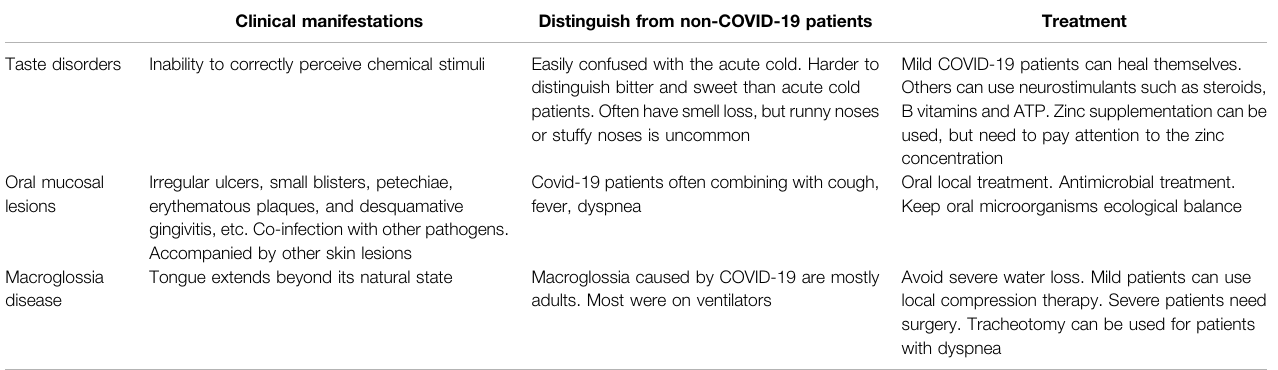
TABLE 1 | The guidelines for diagnosis and treatment of the oral complications of COVID-19 patients. Clinical manifestations Distinguish from non-COVID-19 patients